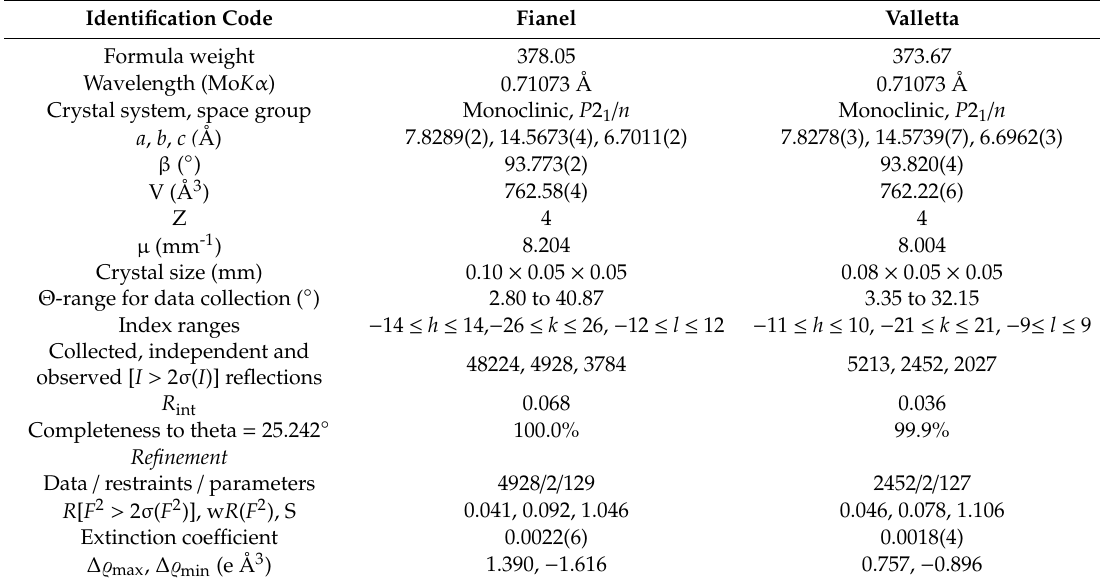
Table 3. Crystal Data and Structure Refinement for Rüdlingerite Holotype from the Fianel Mine and Cotype from the Valletta